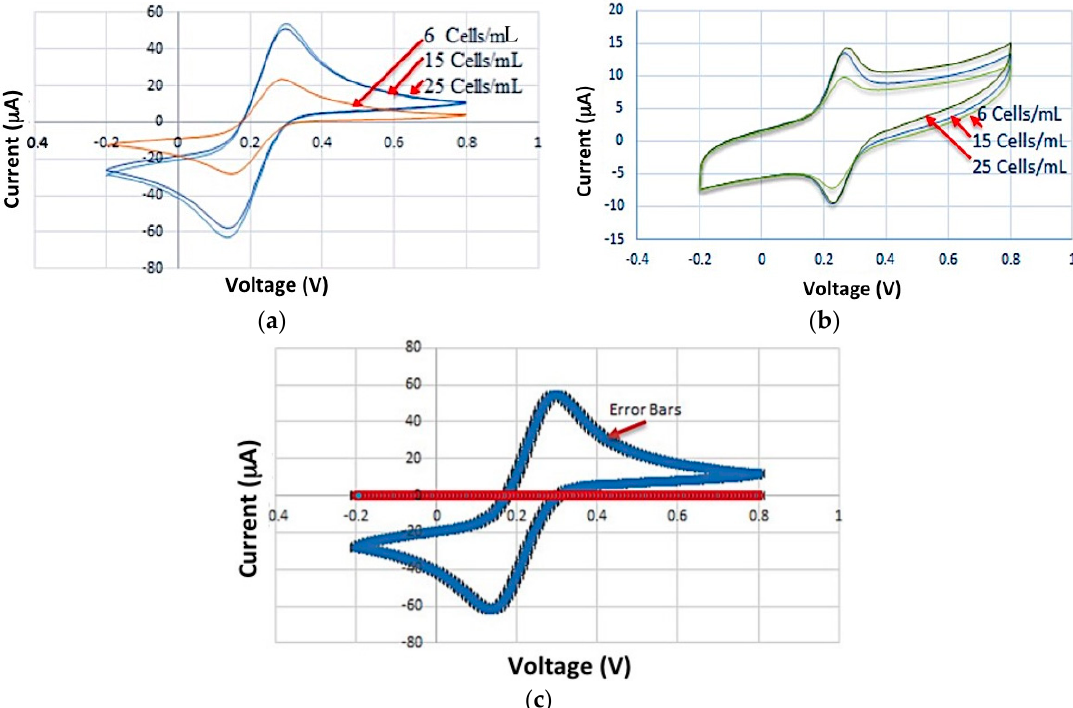
Figure 5. Cyclic voltammetry results related to ( a ) the test of apta-DS exposed to HCT116 cells at various concentrations of 6, 12 and 25 cells/mL; ( b ) the test of apta-DS exposed to HEp-2 cells at various concentrations of 6, 12 and 25 cells/mL and ( c ) the correspondence of cancer and control cells on the same curve. Each experiment related to CV curves was repeated more than three times.